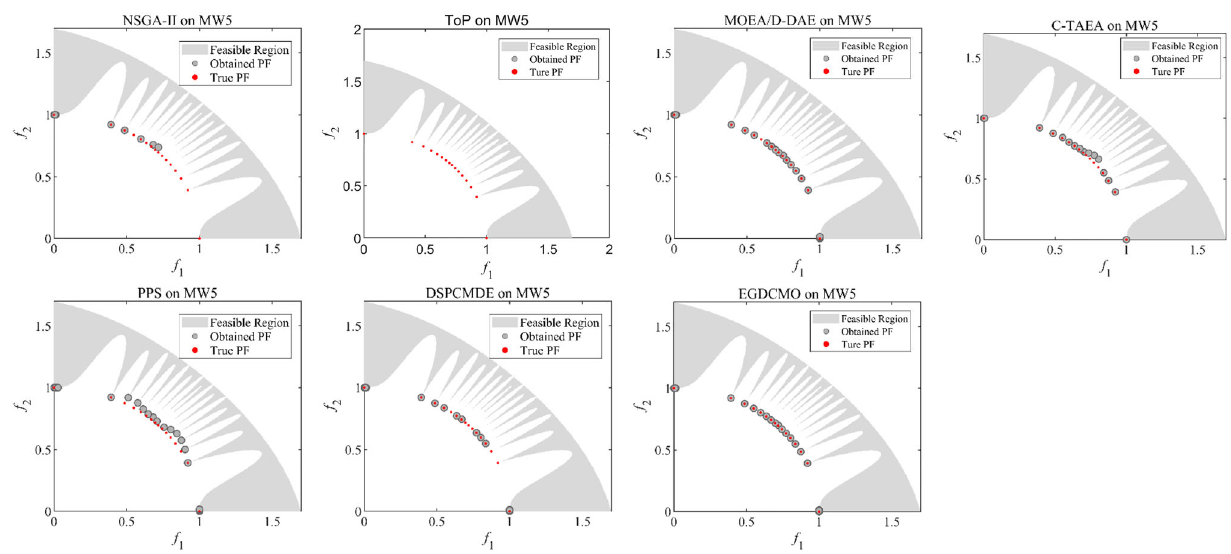
Fig. 12 Pareto front with median IGD value obtained by the proposed EGDCMO and all the compared CMOEAs on MW5